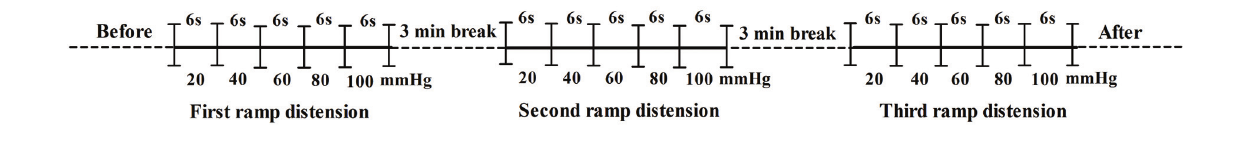
FIGURE 1 | Scheme for CRD and